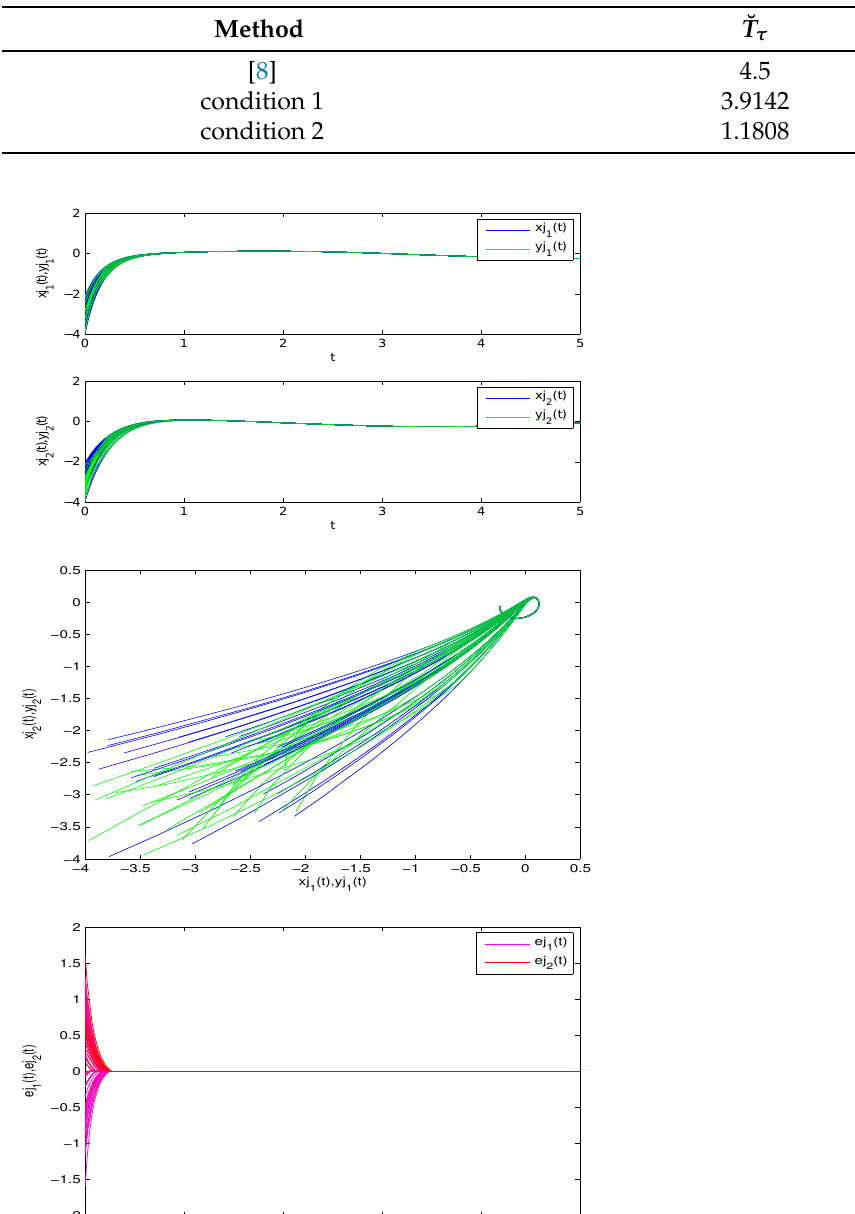
Table 3. The comparison of the different fixed time ˘ T τ .